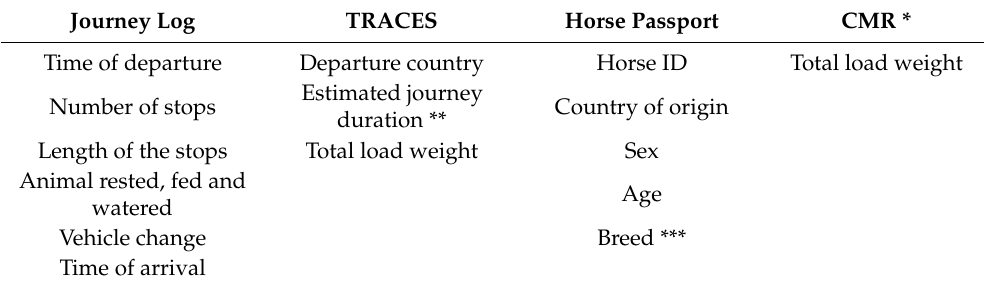
Table 1. List of information compared or retrieved from the official